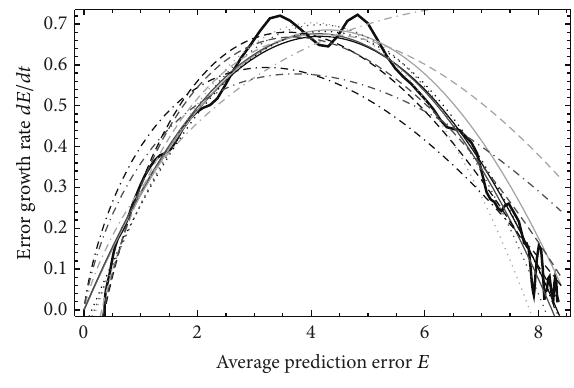
Figure 6: As Figure 5 for ND 3 , 𝑀 5 .